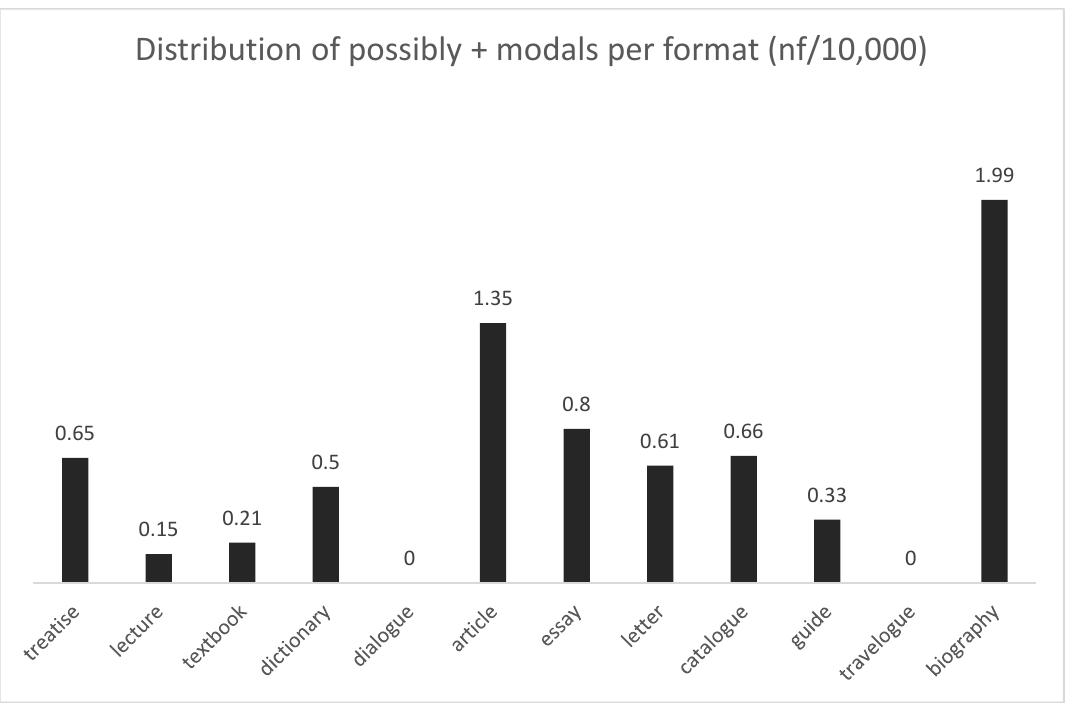
Figure 7. Use of possibly with modals per communicative format.